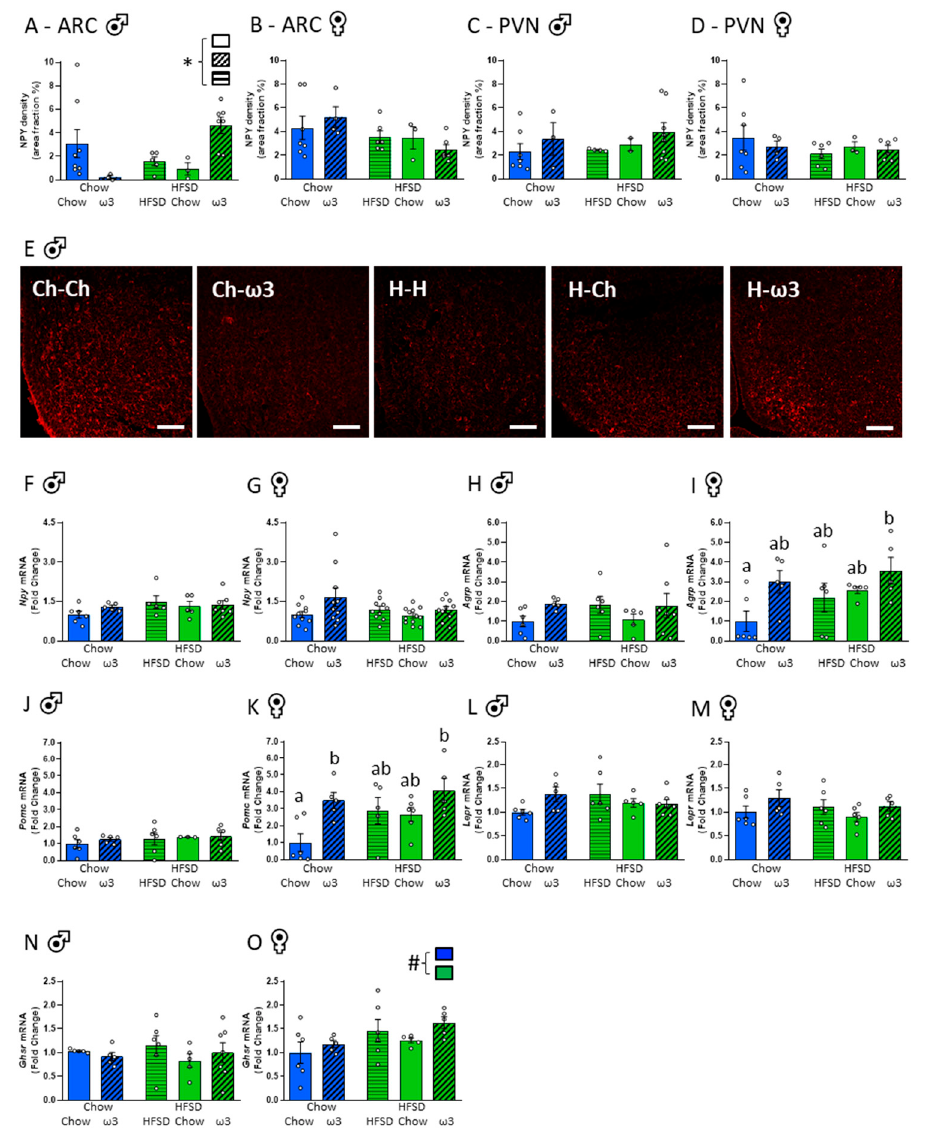
Figure 5. Effects of maternal pre- and post-conception diet on the hypothalamic satiety system. ( A ) Neuropeptide Y (NPY) density in the arcuate nucleus (ARC), males. ( B ) ARC NPY density, females. ( C ) Paraventricular nucleus (PVN) NPY density, males. ( D ) PVN NPY density, females. ( E ) Representative photomicrographs of NPY-positive cells in the ARC, males. Scale bar = 50 μ m. ( F ) Npy mRNA, males. ( G ) Npy mRNA, females. ( H ) Agouti-related peptide ( Agrp) mRNA, males. ( I ) Agrp mRNA, females. ( J ) Pro-opiomelanocortin ( Pomc ) mRNA, males. (K) Pomc mRNA, females. ( L ) Leptin receptor ( Lepr ) mRNA, males. ( M ) Lepr mRNA, females. ( N ) Growth hormone secretagogue receptor ( Ghsr ) mRNA, males. ( O ) Ghsr mRNA, females. HFSD: high-fat-high-sugar diet; Ch: chow (in D ). Letters denote post hoc differences between groups; * significant effect of post-conception diet; # significant effect of pre-conception diet ( p < 0.05). Data are mean ± SEM ( n = 3–10). Each data point represents one pup per litter per sex.